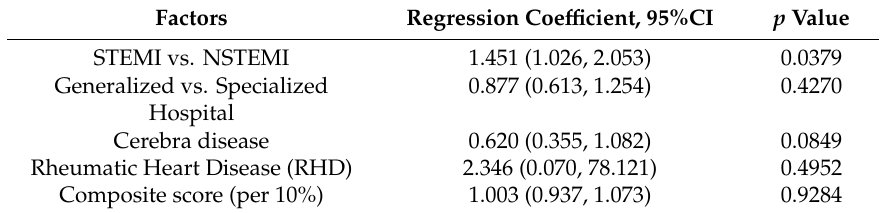
Table 5. E ff ect of patient composite scores on in − hospital mortality.